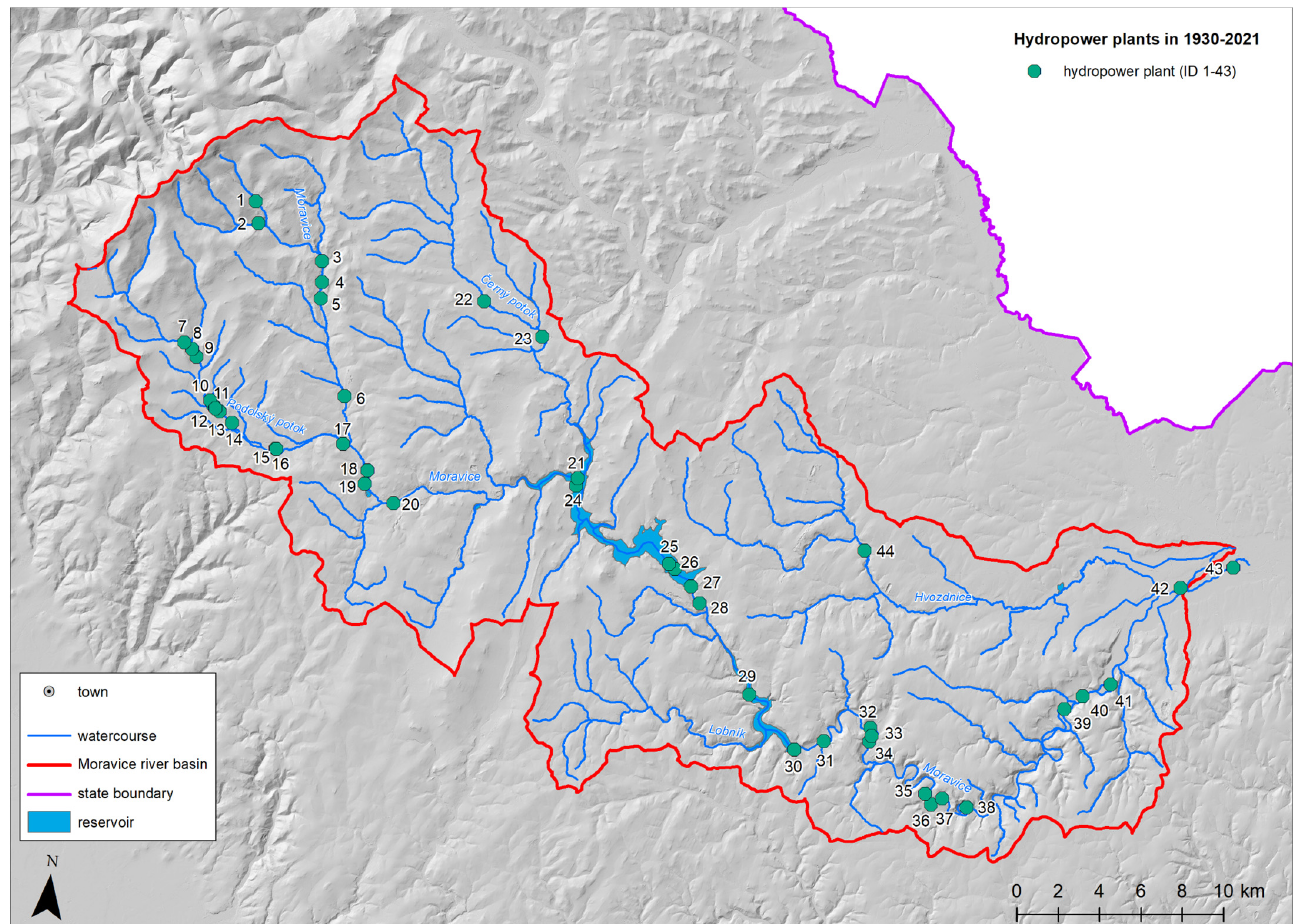
Figure 5. Hydropower plants between 1930 and 2021. The numbers refer to those in Table 4.